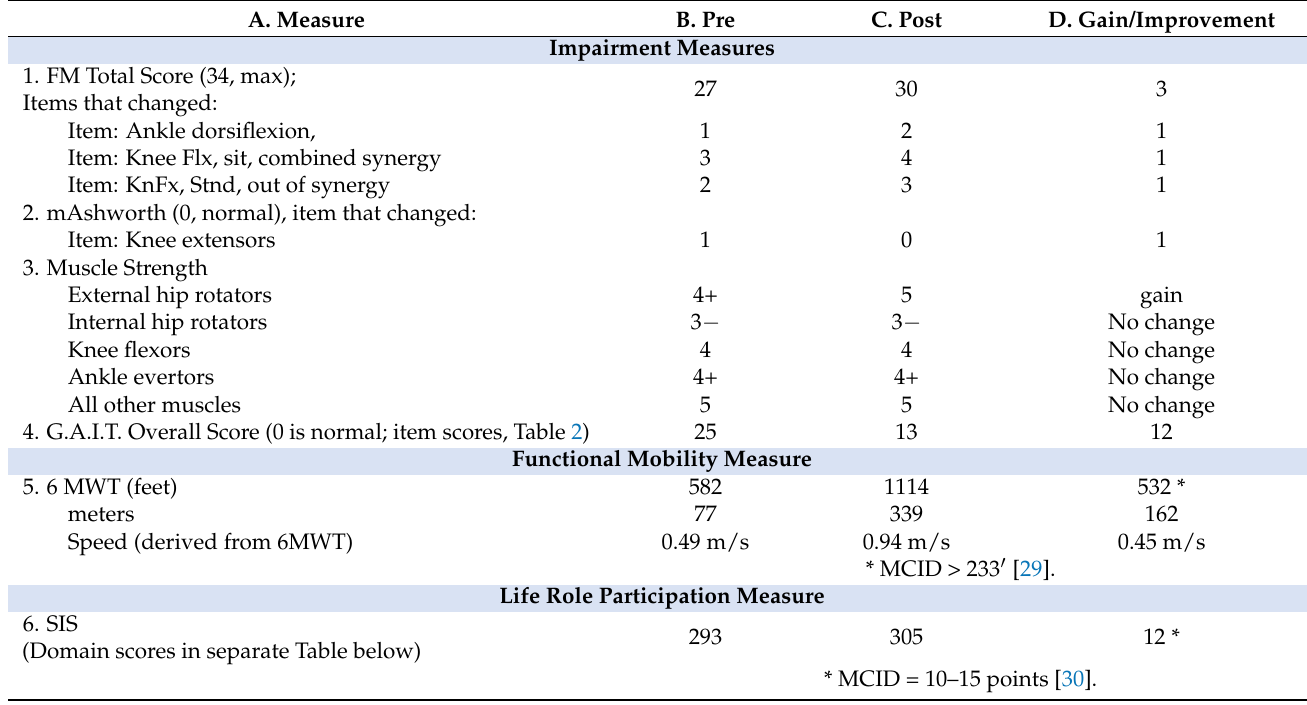
Table 1. Results for Impairment, Mobility Function, and Life Role Participation